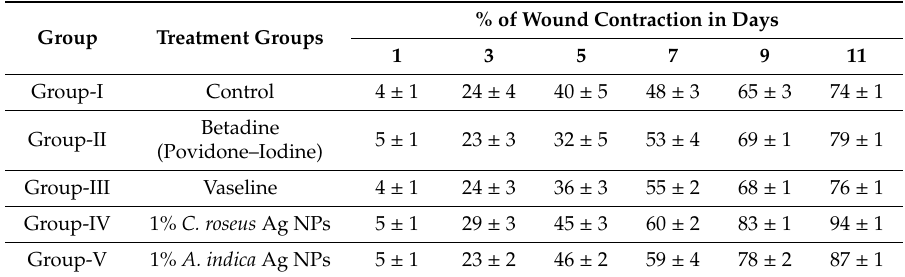
Table 2. Percentage of wound contraction in BALB / c mice excision wound model. Note: mean ±